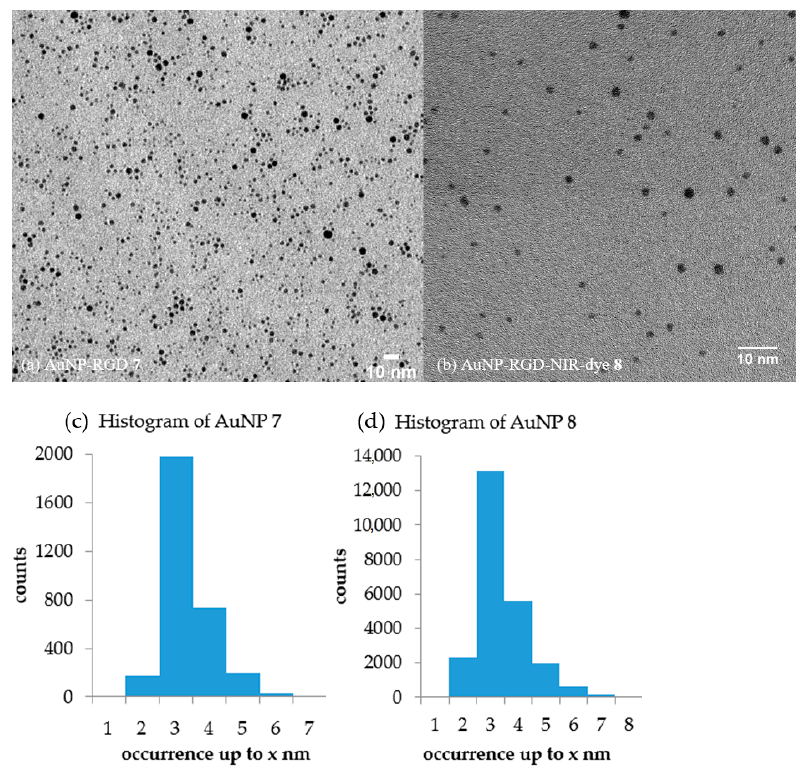
Figure A11. Transmission electron microscopy of ( a ) AuNP-RGD 7 (A = 6.64 nm 2 , Ø = (2.91 ± 2.27) nm, n = 3100) and ( b ) AuNP-RGD-NIR-dye 8 (A = 7.44 nm 2 , Ø = (3.08 ± 2.57) nm, n = 23,900) and the respective histograms ( c ) and ( d ) of the AuNP diameter distribution.